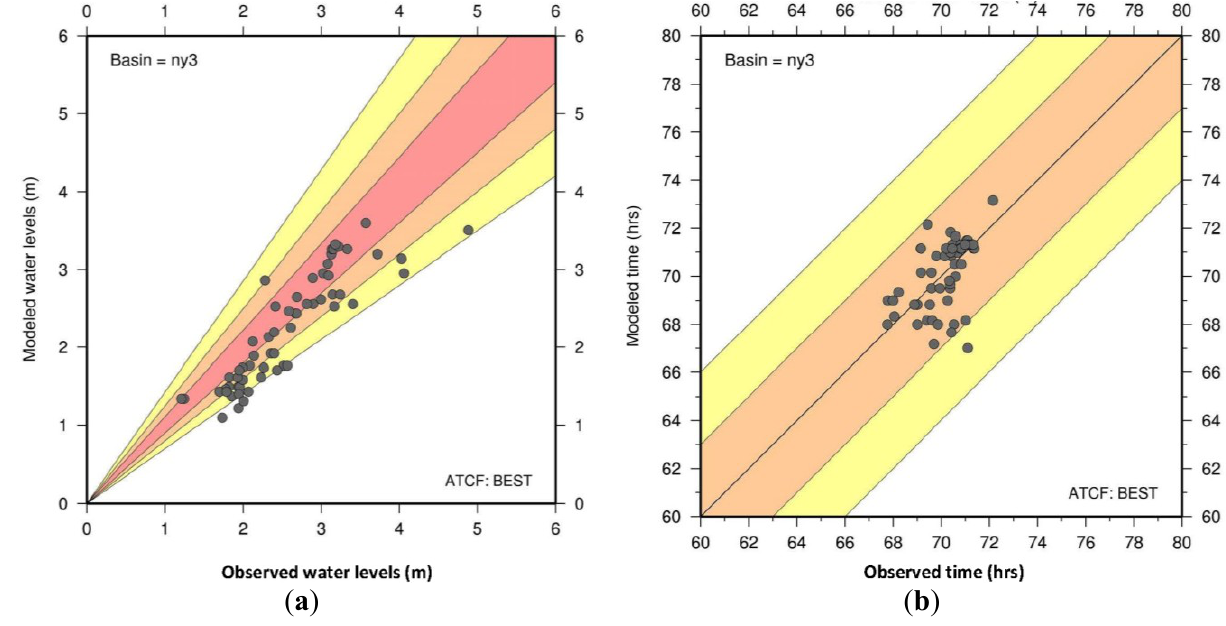
Table 6. USGS Storm Surge Sensors vs. SLOSH Peak Arrival Times and Water